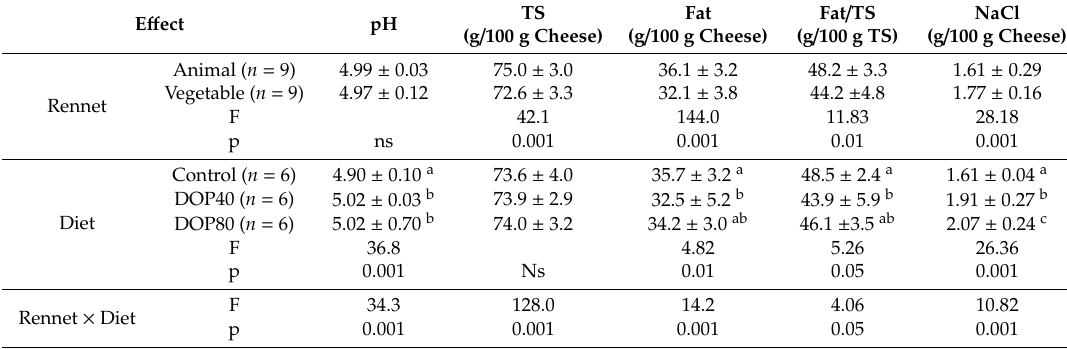
Table 2. Descriptive measures (mean and standard deviation) and analysis of variance (rennet × diet) of physicochemical parameters (F and probability